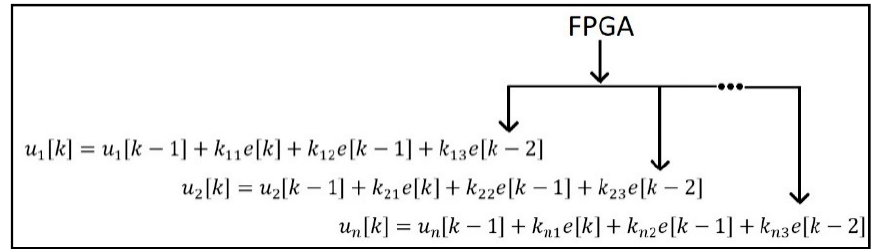
Figure 5. Multiple PID controller equation for FPGA.